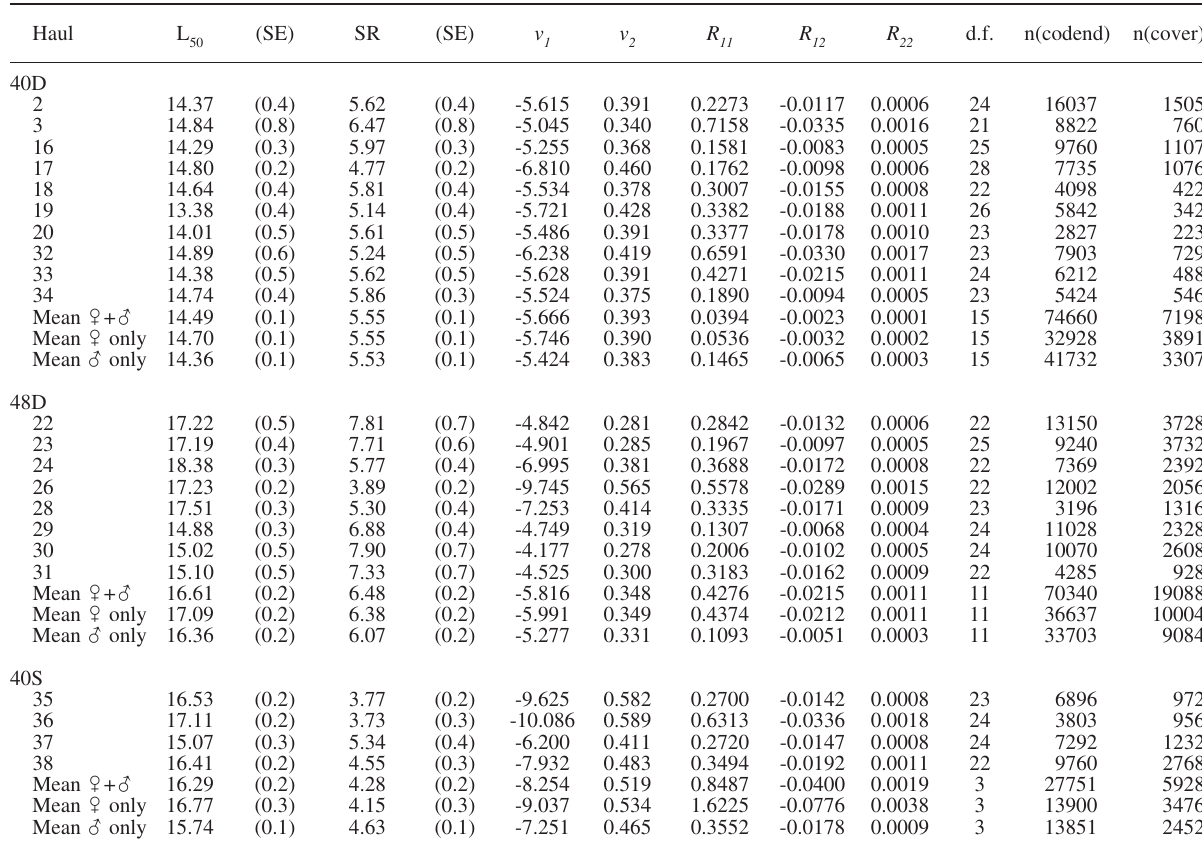
Table 1. – Results of selectivity parameter estimates, and number of specimens in codend and cover of 40d (40 mm diamond mesh), 48d (48 mm diamond mesh), and 40s (40 mm square mesh) for combined ( / + ? ), male only ( ? ), and female only ( / ) specimens. numbers in brack- ets are standard errors. l , fifty percent retention length; ν and ν , maximum likelihood estimators of the selectivity parameters; r 1 2 50 r , variance matrix measuring the within-haul variation; d.f., degrees of freedom; n, the numbers of individuals in the codend and 22